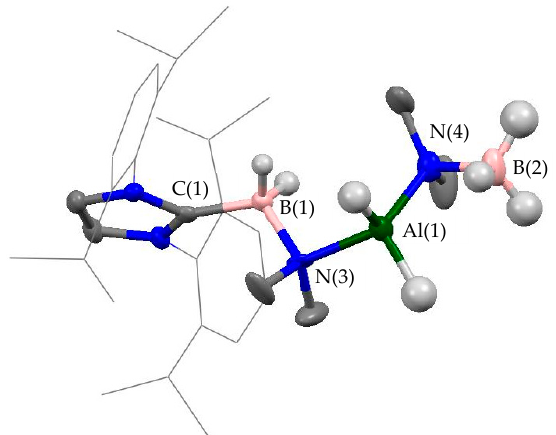
Figure 6. Molecular structure of compound 9 in the solid state with thermal ellipsoids set at the 50% probability level. Hydrogen atoms (except those on B(1), B(2), and Al(1)) are omitted for clarity, and diisopropylphenyl substituents on the NHC ligand are depicted in wireframe for simplicity. Selected bond lengths (Å) and angles (°): C(1)–B(1) 1.628(3), B(1)–N(3) 1.555(6), N(3)–Al(1) 2.026(5), N(4)–Al(1) 1.948(6), B(2)–N(4) 1.599(6), C(1)–B(1)–N(3) 115.6(2), B(1)–N(3)–Al(1) 108.0(3), N(3)–Al(1)–N(4) 112.89(2), Al(1)–N(4)–B(2) 95.7(3).